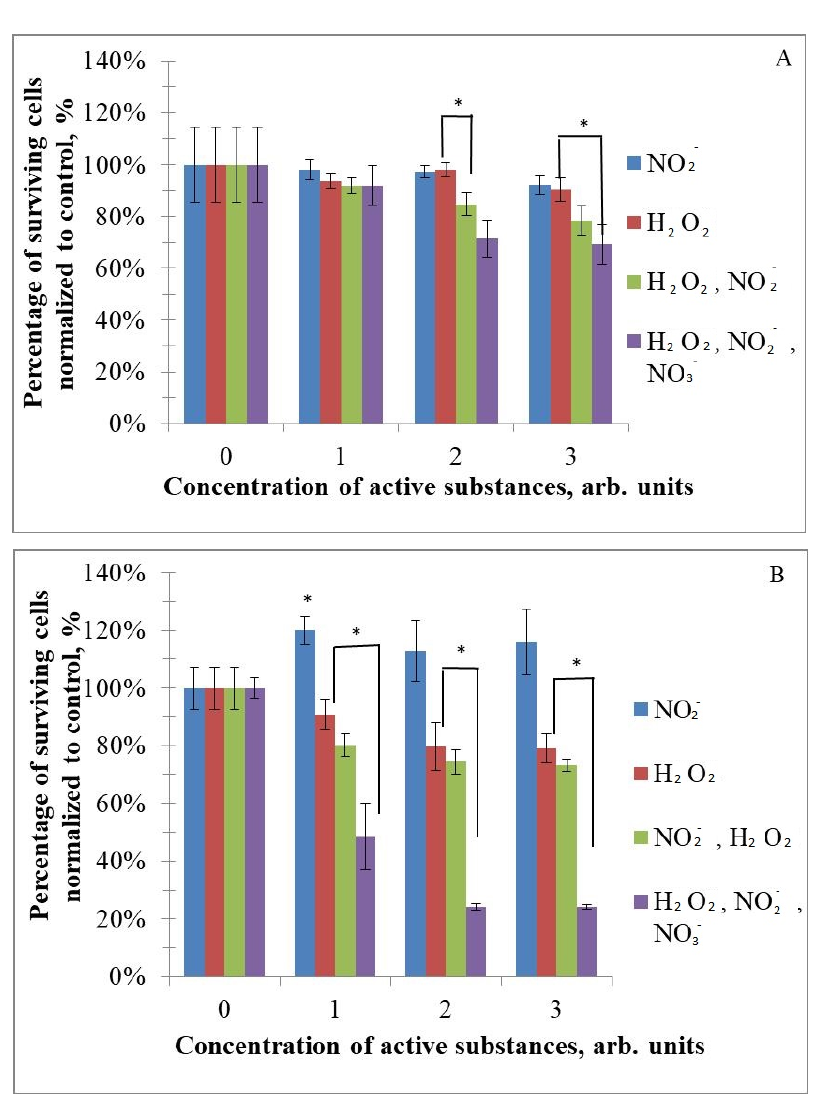
Figure 8. Dependence of the level of damage to the DNA cells on the time of processing by the di- rect piezodischarge of the physiological solution added to the nutritional medium. The cells were kept in the RPMI nutritional medium with the addition of 10% fetal bovine serum, amphotericin, and gentamycin, in a thermostat with increased CO 2 concentration (5%) at temperature of 37 °C. In detail, the experimental conditions are described in the Section 2 Figure 9 shows that the chemically prepared solution of nitrites, nitrates, and hy- drogen peroxide has a similar effect on the mononuclear leucocytes and a stronger cyto- toxic effect on the mieloblastosis cells than the physiological solution treated by the direct piezodischarge. In this case, there was a correlation between the MTT test and the trypan blue dye.